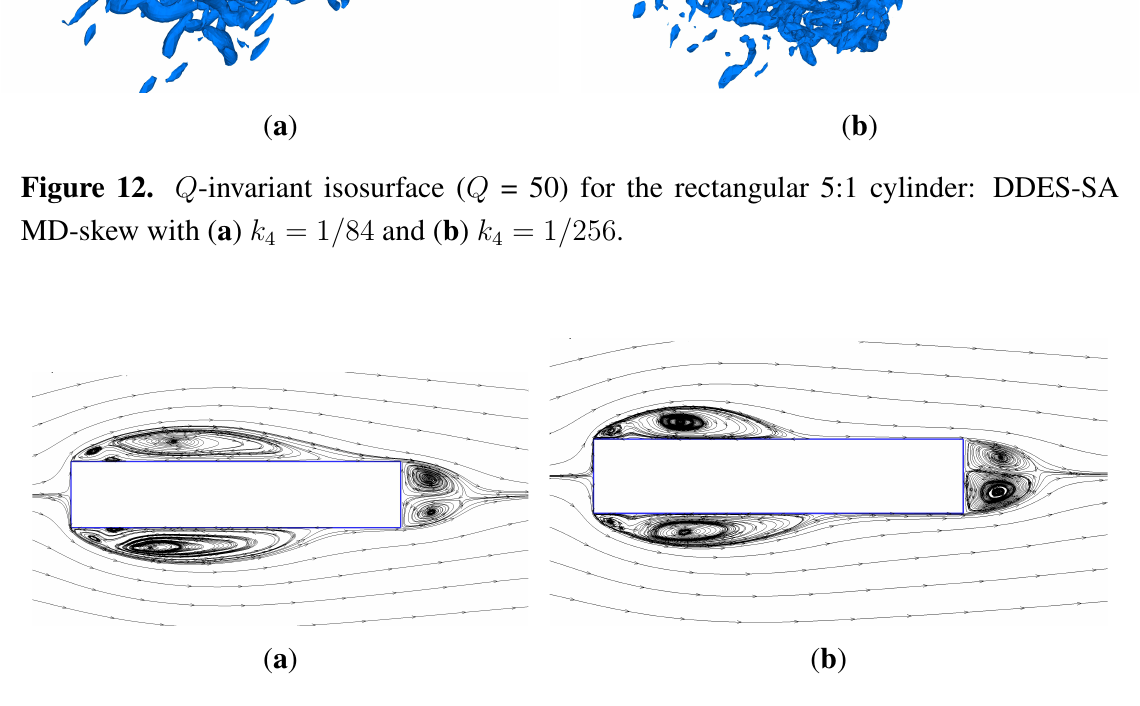
Figure 13. Streamlines of the time-averaged flow field for the rectangular 5:1 cylinder: DDES-SA MD-skew with ( a ) k